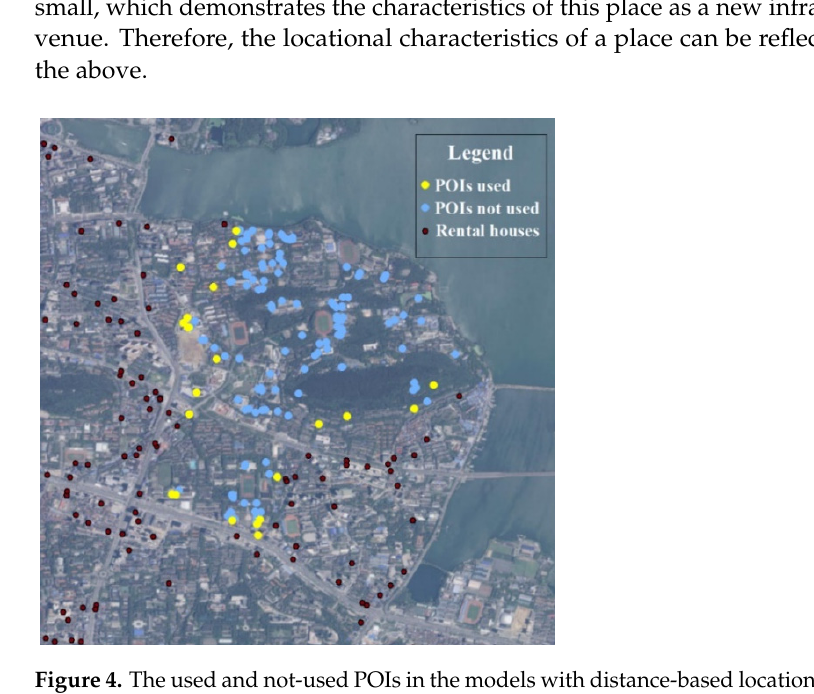
Figure 4. The used and not-used POIs in the models with distance-based locational and neighborhood variables.